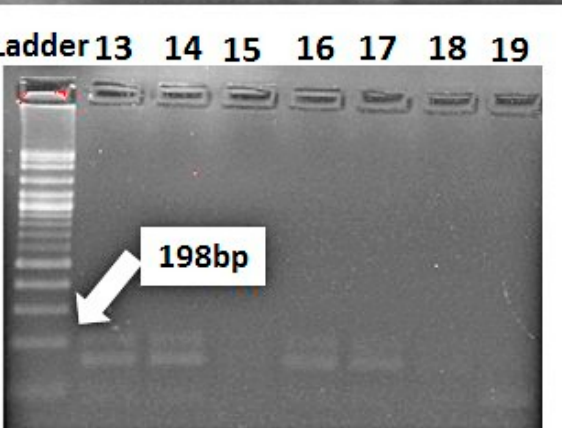
Figure 7. Electrophoretic amplified pattern of DNA extracted from 19 wheat genotypes using the specific primer of Lr67/Yr46 . Lane 1 = Misr-3, Lane 2 = Misr-4, Lane 3 = Misr-2, Lane 4 = Misr-1, Lane 5 = Sids-13, Lane 6 = Gemmeiza-9, Lane 7 = Gemmeiza-12, Lane 8 = Sakha-94, Lane 9 = Sakha-95, Lane 10 = Giza-168, Lane 11 = Gia-171, Lane 12 = Giza-139, Lane 13 = Sids-12, Lane 14 = Sakha-61, Lane 15 = Sids-14, Lane 16 = Gemmeiza-5, Lane 17 = Gemmeiza-7, Lane 18 = Gemmeiza-10, and Lane 19 = Shandweel-1.